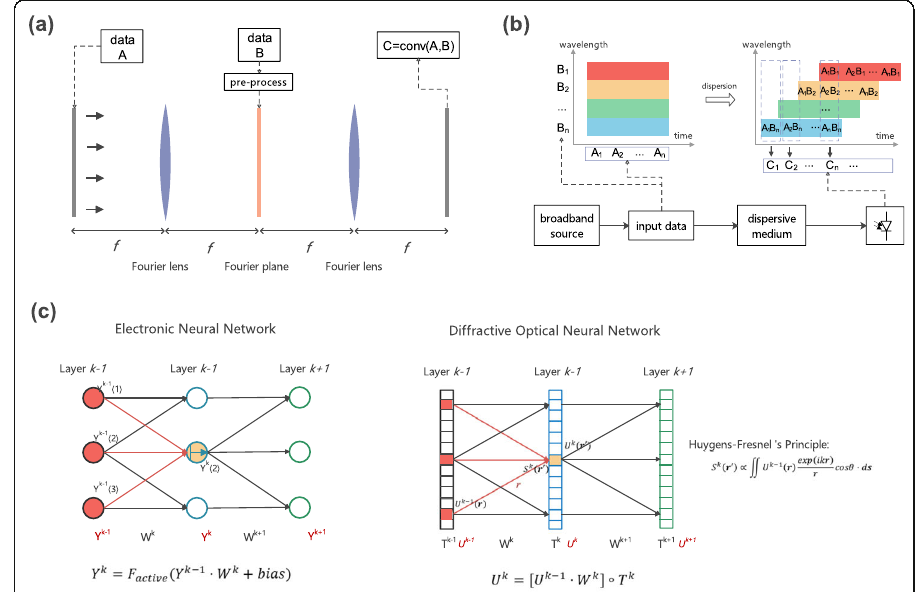
Fig. 2 Complex matrix manipulation in optical computing. a 4F system. Two gray bars represent input data ( A ) and convolution results ( C ). The convex lens is Fourier lens that implements Fourier transform. The orange bar represents a matrix. b Schematic of optical convolution processor based on dispersion effect. c Schematic of diffractive deep neural networks with multi-layers of passive diffractive